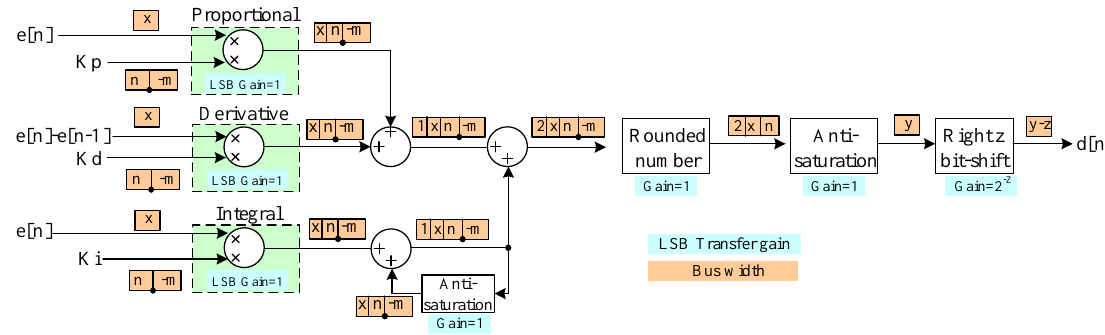
Figure 7. proportional–integral–derivative (PID) compensator block diagram. Figure 7. Proportional–integral–derivative (PID) compensator block